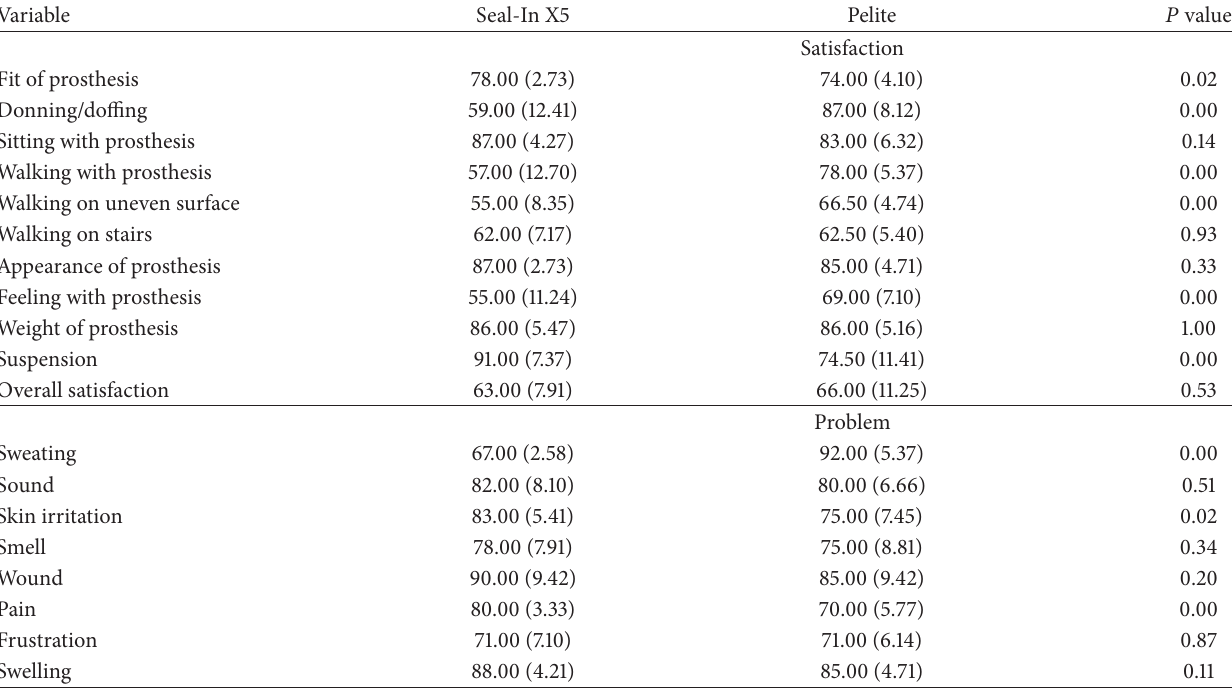
Table 5: Comparison between Seal-In X5 and Pelite